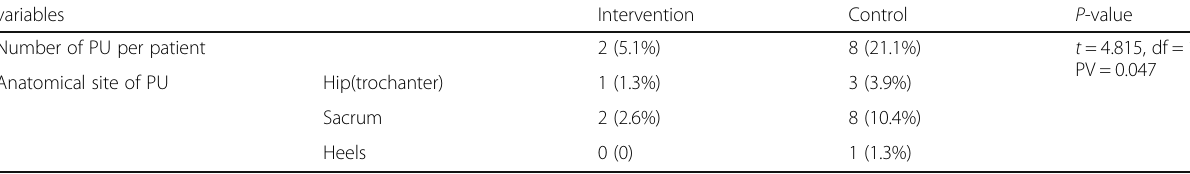
Table 3 Frequency of Pressure Ulcers among two groups variables Intervention